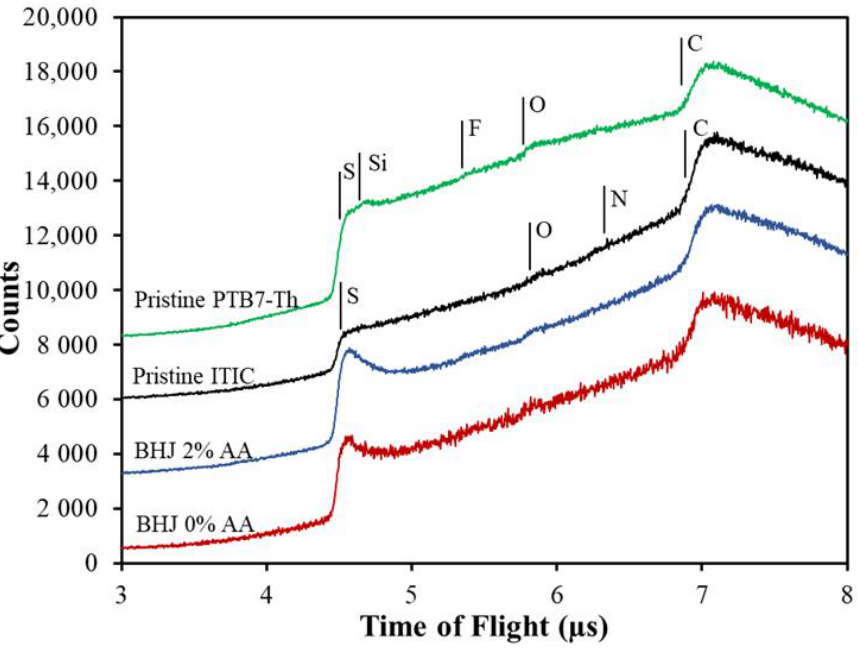
Figure 2. NICIS TOF spectra of PTB7-Th, ITIC, and a 1:1.3 blend of PTB7-Th and ITIC. Signal onset of helium backscattered from sulphur, silicon, oxygen, nitrogen, and carbon is marked by vertical bars. The spectra are offset vertically for clarity.